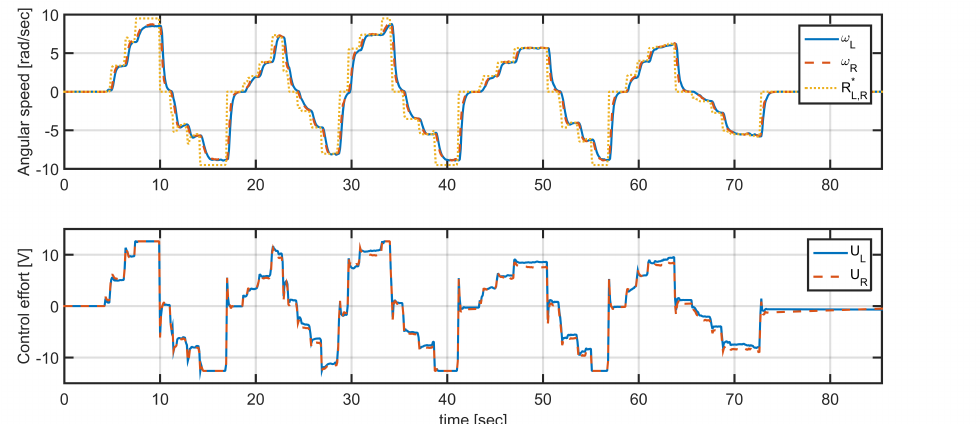
Figure 9. Speed setting of one of the left motors (blue) and one of the right motors (red) with respect to the angular speed reference (yellow). The horizontal axis is in samples, with a sample time T s = 0.1